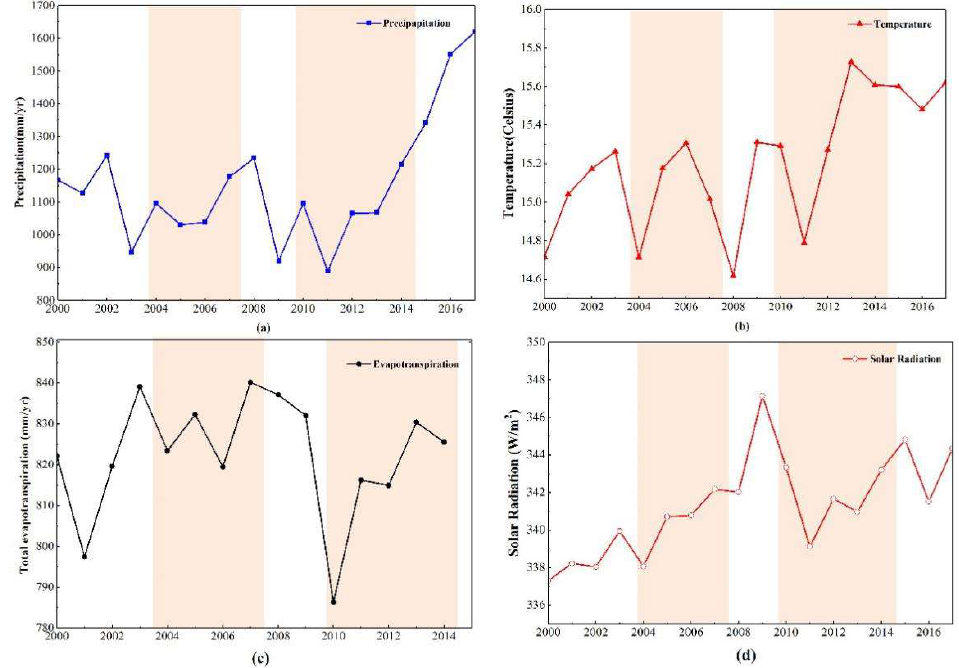
Figure 7. Variations of ( a ) precipitation, ( b ) temperature, ( c ) evapotranspiration and ( d ) solar